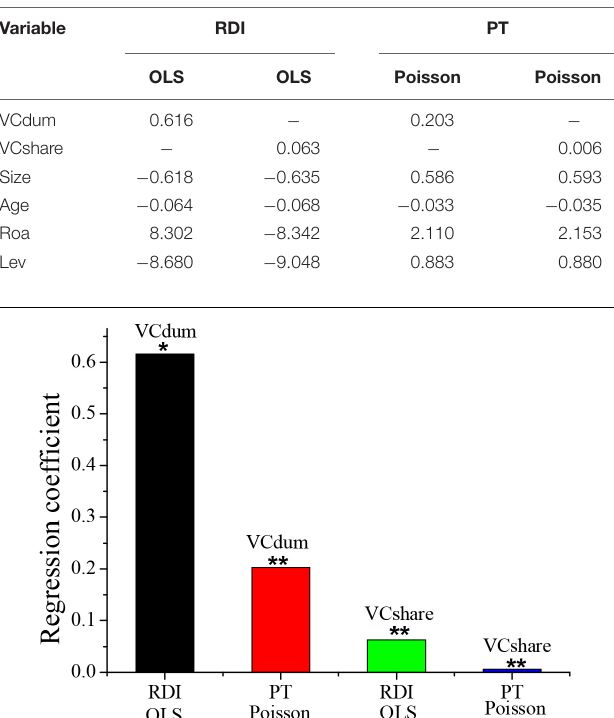
*Indicates a significant positive correlation at the 1% level.